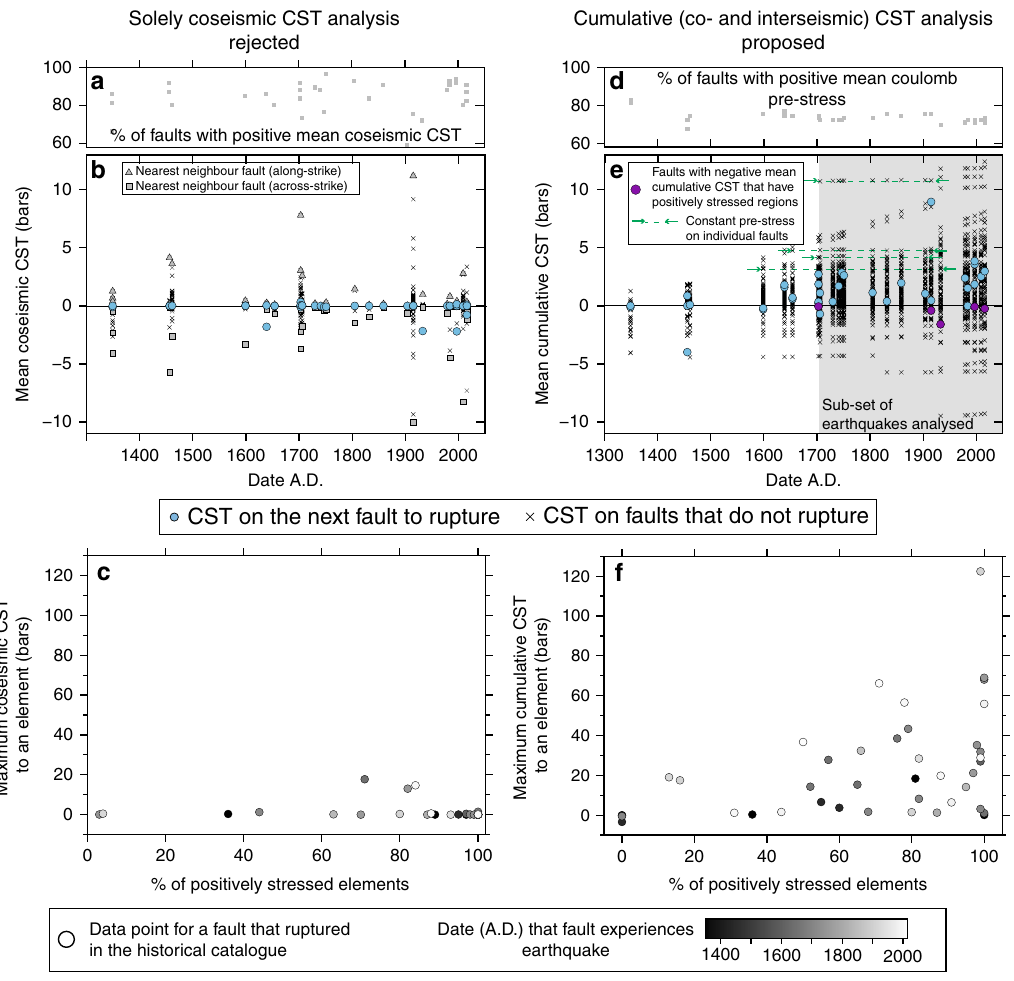
Fig. 4 Analysing the Coulomb stress evolution on faults over time. Two approaches are considered; solely coseismic CST (rejected herein) and the proposed approach of this paper to analyse cumulative CST and Coulomb pre-stress. Vertical scales are comparable between sub- fi gures a and d , b and c , and d and f to assist direct comparison of the two approaches. a Percentage of all faults in the Apennines that have mean positive coseismic CST after each historical earthquake. b Mean coseismic CST on faults that do and do not rupture. The fault that ruptures (pale blue circles) never has the highest mean coseismic CST prior to rupture (grey triangles for the nearest-neighbour fault along-strike). c Considering the maximum stress on a single fault element and the proportion of the fault that is positively stressed prior to rupture. d Percentage of all faults in the Apennines that have mean positive Coulomb pre- stress prior to each earthquake in the historical catalogue. The proportion of faults that are positively stressed is fairly consistent and high, indicating that most faults are critically stressed. e Mean cumulative (interseismic and coseismic) CST on faults that do and do not rupture. The fault that ruptures (pale blue circles) is never the fault with the highest mean cumulative CST. The grey shaded region indicates the sub-set of earthquakes analysed (earthquakes since 1703 A.D.) to reduce the bias towards the initial conditions of the model. f Considering the maximum cumulative CST on a single fault element and the proportion of the fault that is positively stressed prior to rupture. The dots representing faults that rupture are colour-coded according to date, indicating that there is no correlation between time of earthquake and the maximum cumulative CST. The magnitude of cumulative CST is several orders of magnitude higher than for coseismic stress changes alone and the values are more comparable to stress drops calculated for large earthquakes. The data and analysis presented in this fi gure are detailed in Supplementary Data